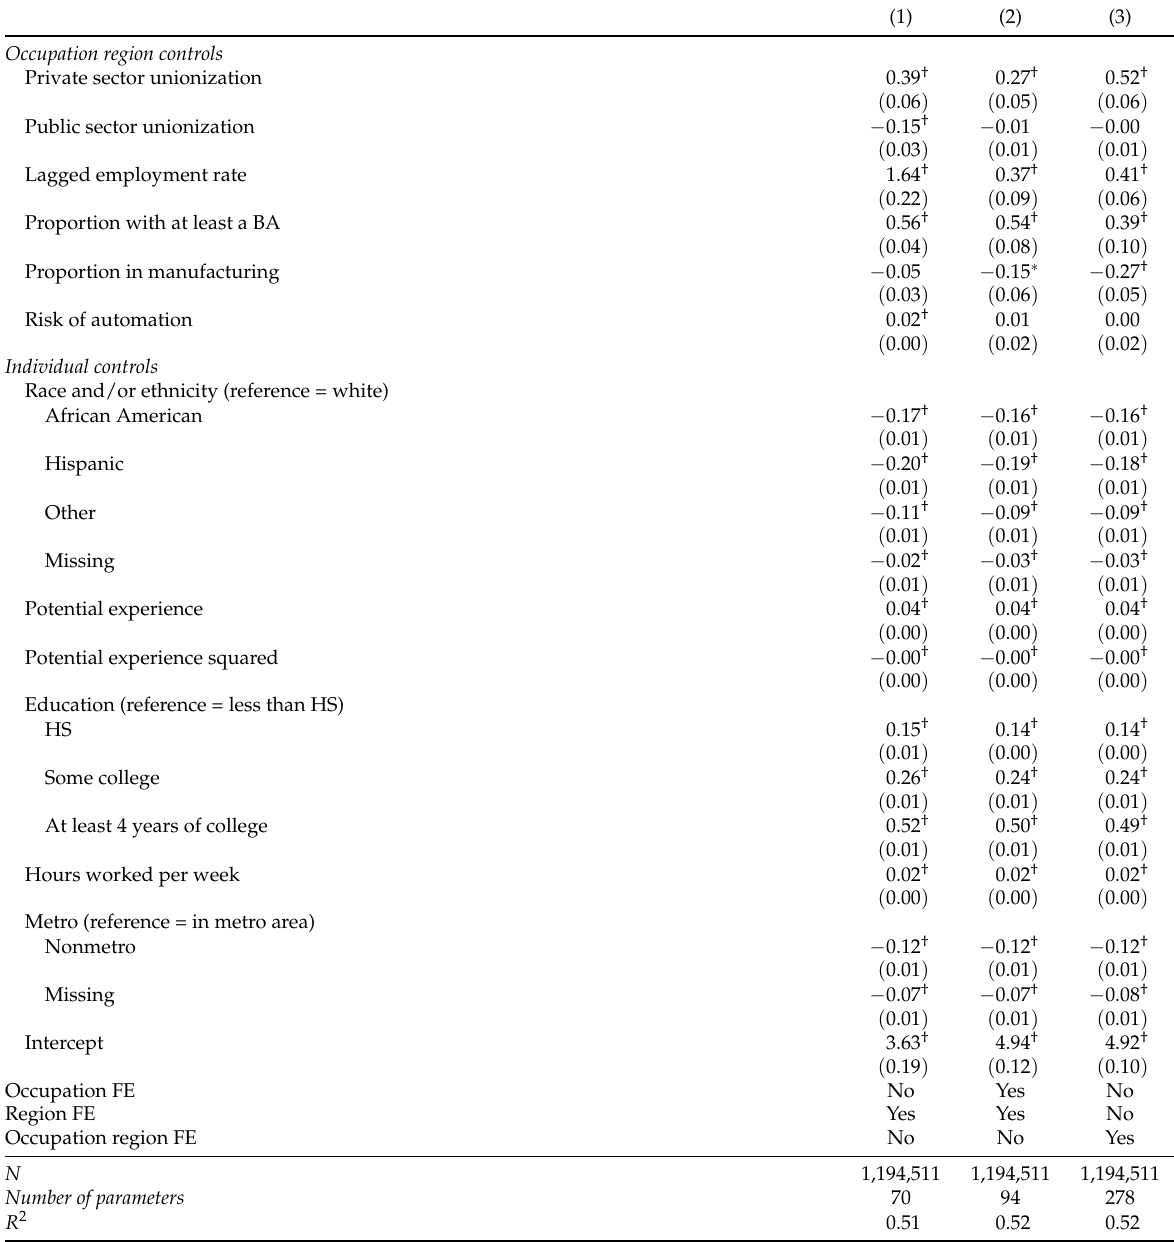
Table 2: Effects of private sector occupation region unionization on nonunion, private sector log weekly wages, 1977–2015